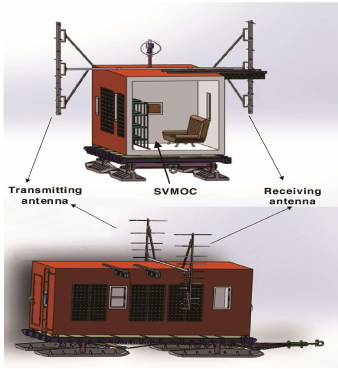
Figure 2. The position of log-periodic antennas on the snow vehicle. IPR hardware system mounted in the specialized versatile mobile observation cabin